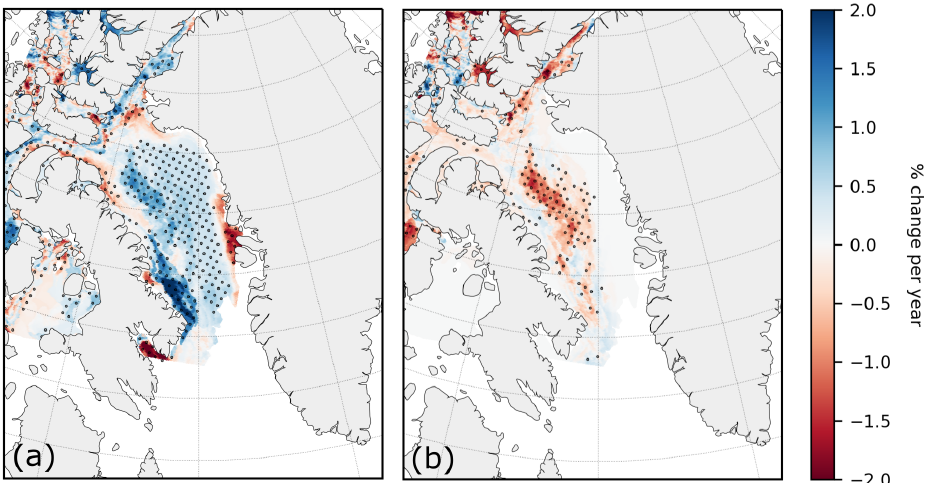
Figure 10. Trend in first-year ice (a) and multi-year ice (b) from the Canadian Ice Service charts (1996–2020). Dotted areas show significant trends within p < 0 .